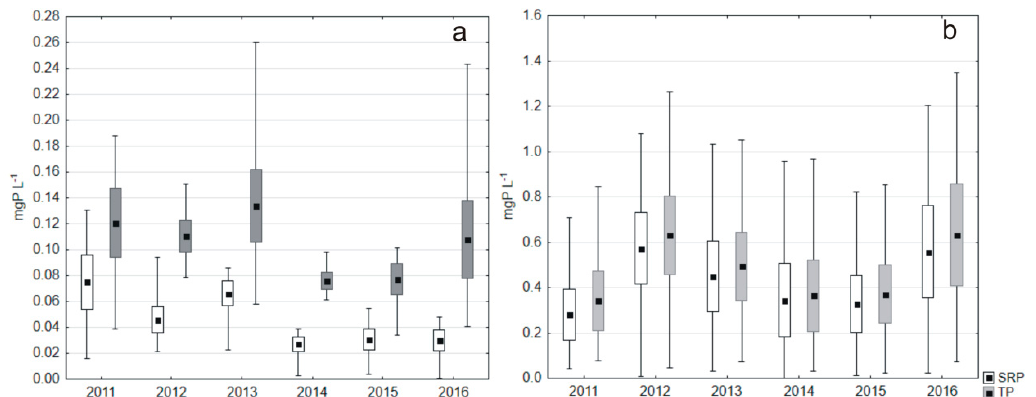
Figure 5. The mean, minimum and maximum concentrations of SRP (soluble reactive phosphorus) and TP (total phosphorus) at the surface ( a ) and above the bottom ( b ) in Swarz ę dzkie Lake in